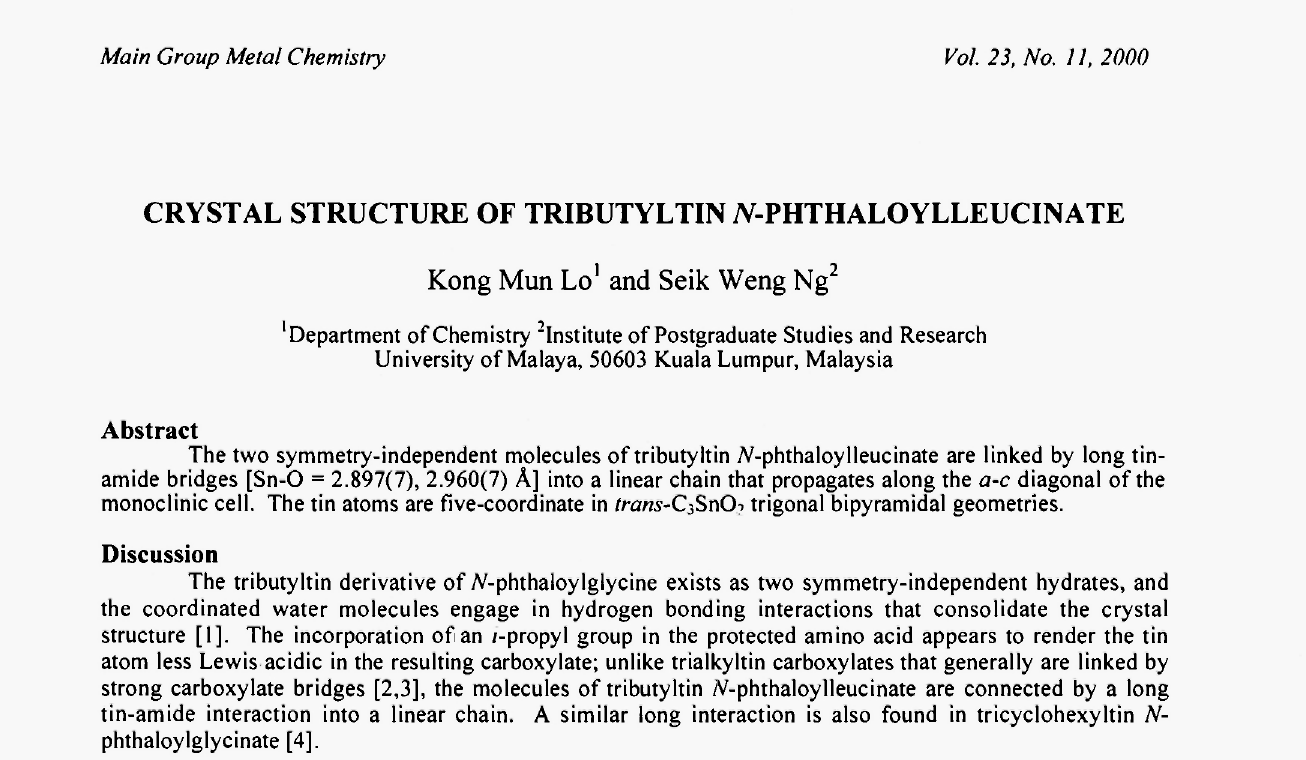
Table 1. Crystal data for tributyltin